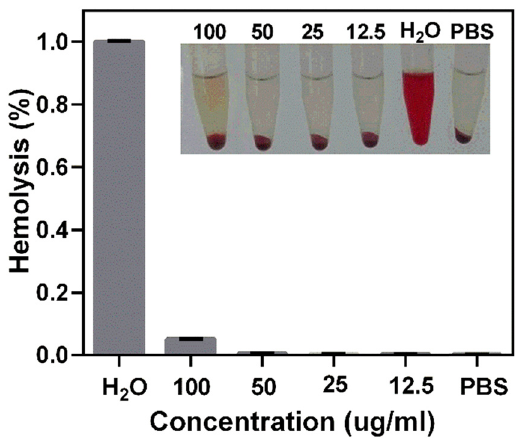
Figure 16: Hemolysis test of BSA/AM